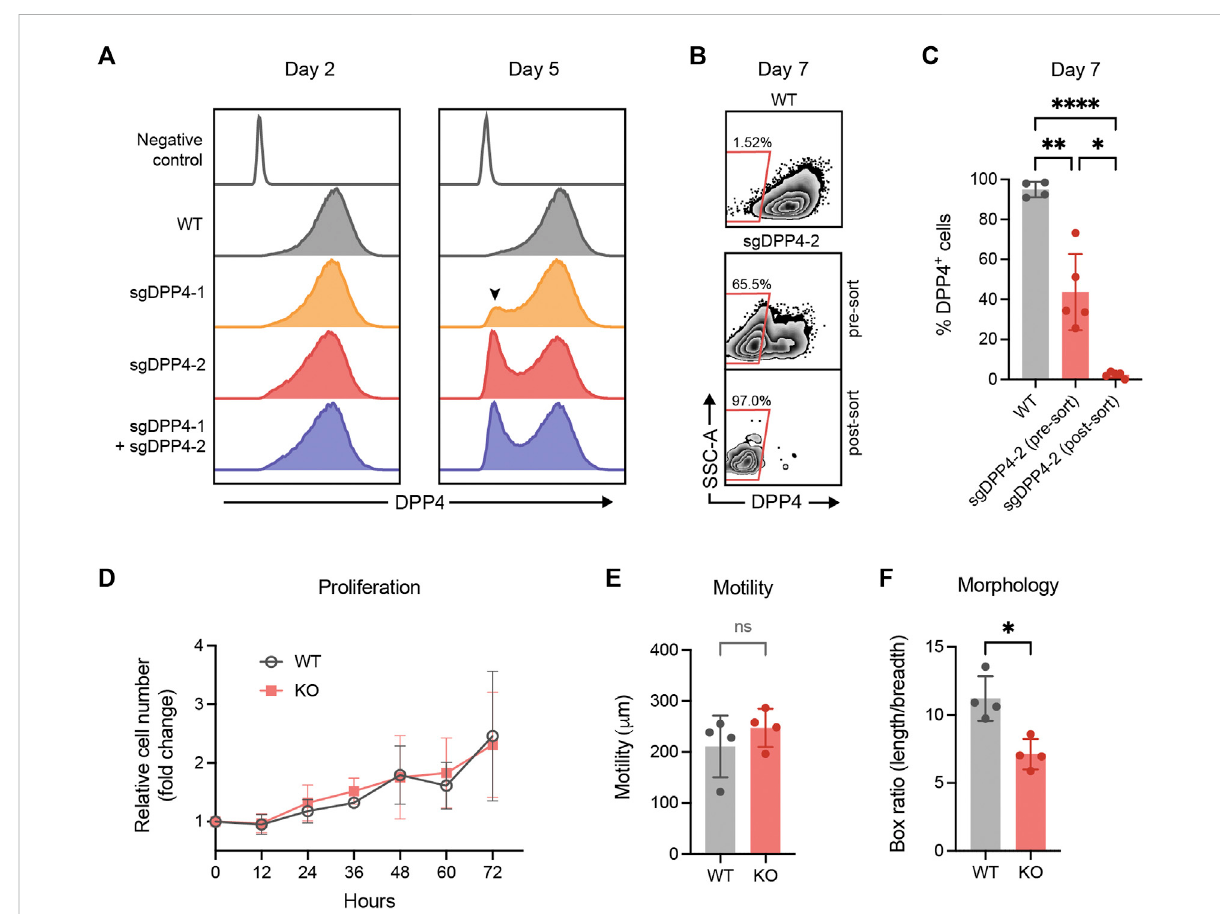
FIGURE 5 CRISPR/Cas9 mediated knockout of DPP4 in primary lung fi broblasts. (A) Histograms show expression of DPP4 on wild-type (WT) lung fi broblasts and lung fi broblasts after CRISPR/Cas9 mediated gene inactivation with two different sgRNAs against DPP4 and their combination. Unstained WT cells are used as a negative control (control). The peak of DPP4 knockout cells is indicated by a arrowhead. Plots show data after forward/side scatter gating and doublet discrimination. (B) Plots show representative fl ow cytometry analysis of DPP4 expression versus side scatter at day 7 on WT cells and on gene edited cells (sgDPP4-2) pre and post sorting by FACS to purify DPP4 - knockout cells. (C) Percentage DPP4 + cells at day 7 for WT cells ( n = 4) and on gene edited cells (sgDPP4-2) pre and post sorting ( n = 5) as determined by fl ow cytometry analysis. Lines represent mean (SD). For statistical analysis, a mixed-effects analysis with Tukey ’ s multiple comparisons test was used. (D) Cell proliferation of WT (greycircles)andDPP4-KO(redsquares)cells(n=4)over72 hpresentedascellnumberfoldchangecomparedto0